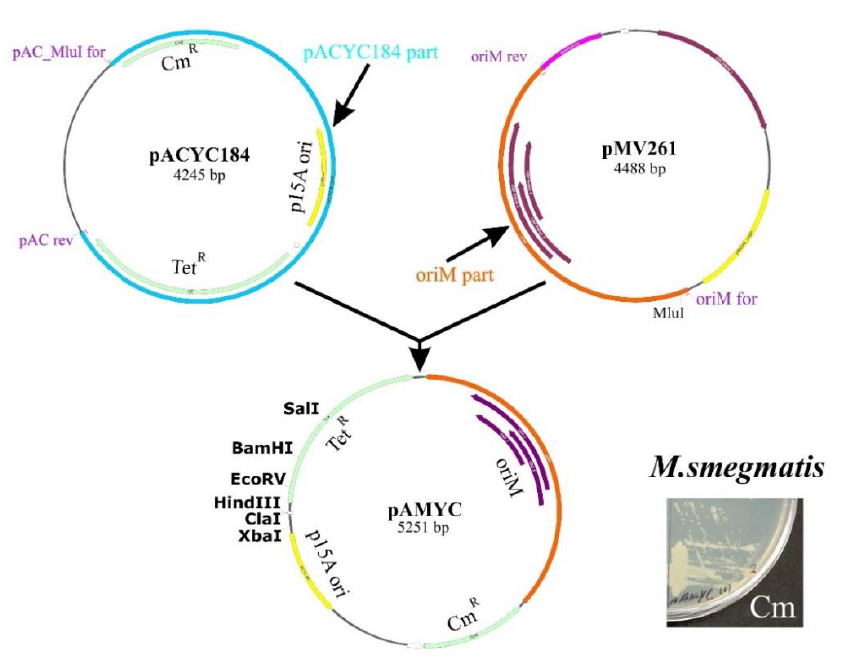
Figure 6. The scheme for creating the novel replicative shuttle vector, pAMYC, a derivative of pACYC184. Transformation of M. smegmatis by pAMYC results in the appearance of chloramphenicol-resistant colonies on LB-Cm plates.